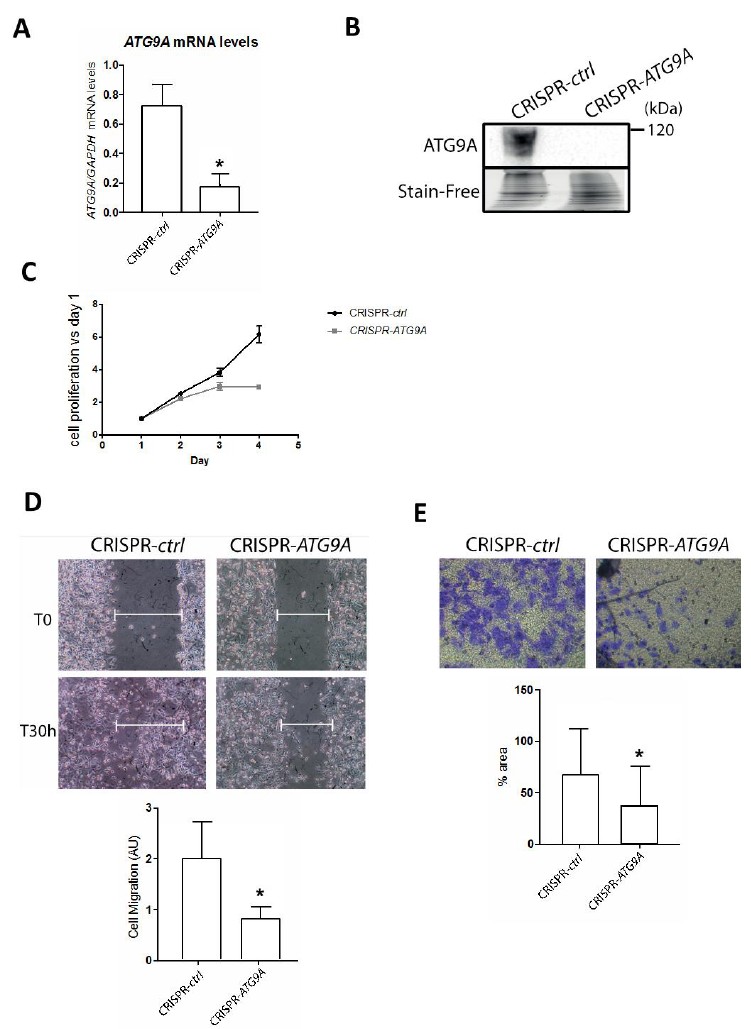
Figure 4. Inhibition of ATG9A expression using CRISPR-Cas9 inhibits in vitro cell proliferation, migration, and invasion in the TNBC cell line MDA-MB-436. ( A ) ATG9A mRNA expression levels quantified by RT-qPCR in the CRISPR- control or the CRISPR- ATG9A clones ( n = 3). Values were normalized using the housekeeping gene GAPDH . The difference of expression was quantified using a t-test. * p ≤ 0.05. ( B ) Level of expression of the ATG9A protein in the CRISPR- control and the CRISPR- ATG9A clones were analyzed by western blotting. A representative image of three independent experiments is shown. ( C ) The proliferation rates of the CRISPR- ATG9A clone and its control were quantified using a MTT assay conducted every day over a 4 day period ( n = 3, 16 replicates). The difference in cell proliferation was quantified using a t-test at day 4. p ≤ 0.05. ( D ) The migration ability of the CRISPR- ATG9A and - control clones were analyzed thanks to a wound healing assay. A representative image of three independent experiments is shown. The difference in cell migration was quantified using a t-test. * p ≤ 0.05. ( E ) The invasion capacity of the CRISPR- ATG9A clone and - control clone was performed in Boyden chambers. A representative image of three independent experiments is shown. The graph represents the percentage of cells which migrated through the ECM-coated Boyden chambers after 24 h, quantification done with the ImageJ software. The difference in cell density was quantified using a t-test. * p ≤